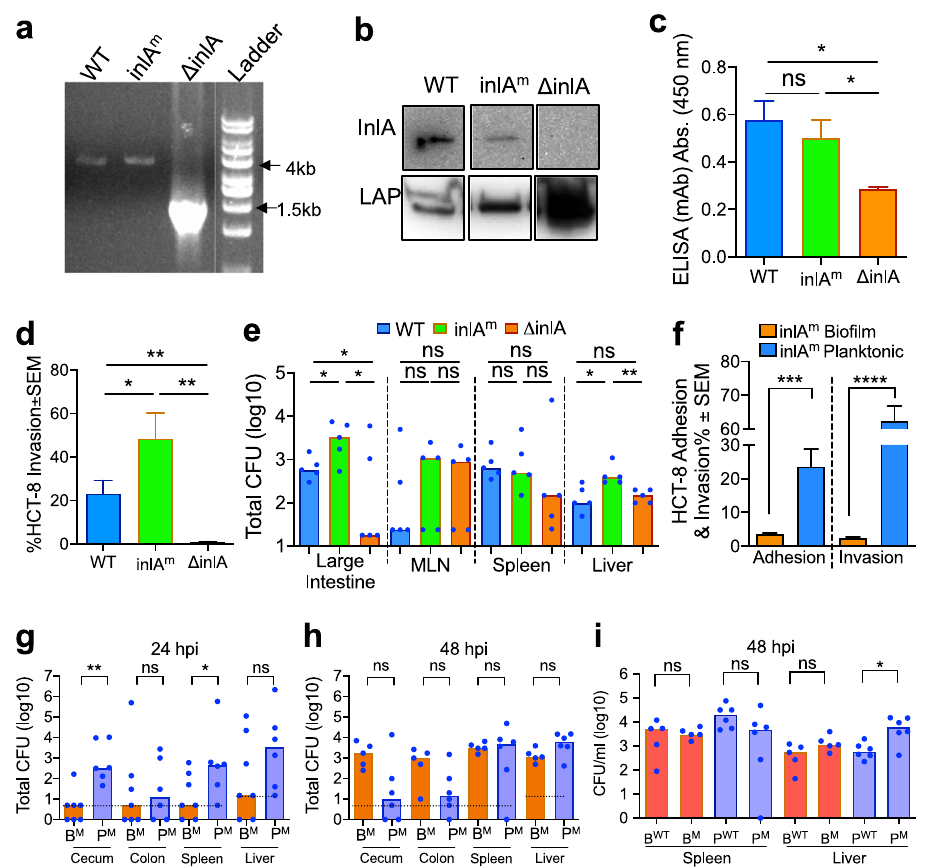
Fig. 7 In mouse bioassay, bio fi lm-isolated and planktonic L. monocytogenes with murinized InlA (InlA m ) display differential tissue distribution. a PCR con fi rmation of the insertion of inlA m gene in the chromosome of Lm F4244 Δ inlA using primers inlA.up.5 and inlA.down.3 (Supplementary Table 2). WT (F4244) was used as a positive control. b Immunoblots showing expression pro fi le of InlA, and LAP in whole-cell extracts of WT, inlA m , and Δ inlA . c ELISA showing the positive reaction of anti-InlA mAb to whole-cell preparation of WT, inlA m , and reduced reaction with Δ inlA . d Percent invasion of WT, inlA m , and Δ inlA to HCT-8 cells. Bars represent mean, and a pairwise Student ’ s t -test was used for statistical analysis. e Lm WT, inlA m and Δ inlA strain burdens in the large intestine, MLN, spleen, and liver of mice ( n = 5 – 6) 96 h after